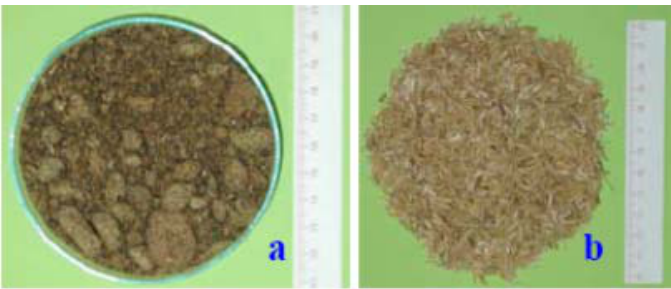
Vietnam (b- rice husks, c- bagasse, d- cassava residues, e- coconut